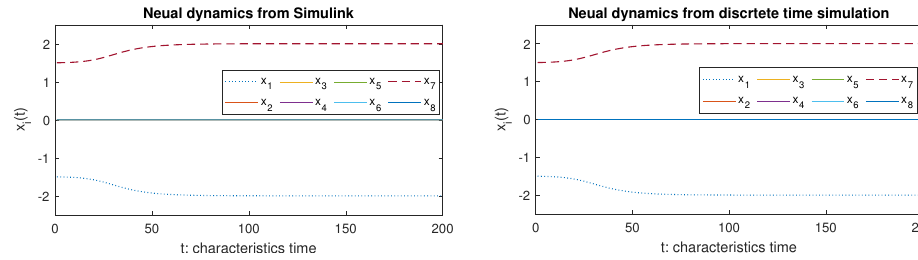
Figure 5. Dynamics obtained from Simulink and discrete time